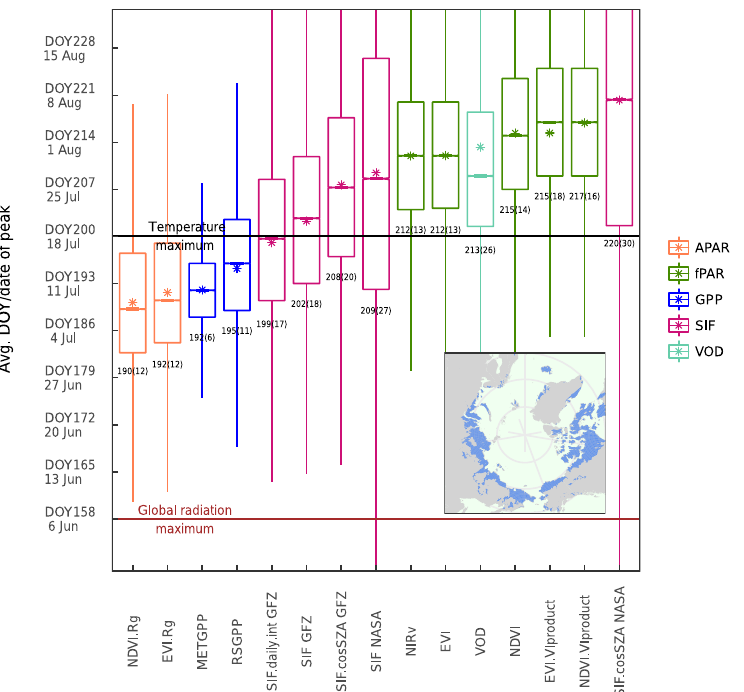
Figure 4. Distribution of the DOY of the peak of the different vegetation proxies over the study region and between years (spatial sampling matched between data sets for each year). Bars in the boxes indicate the median, stars indicate the mean and the numbers below the bars denote the spatiotemporal mean (standard deviation). Colours of the bars denote grouping of the different variables according to the families of fAPAR, APAR, the modelled GPP, SIF and